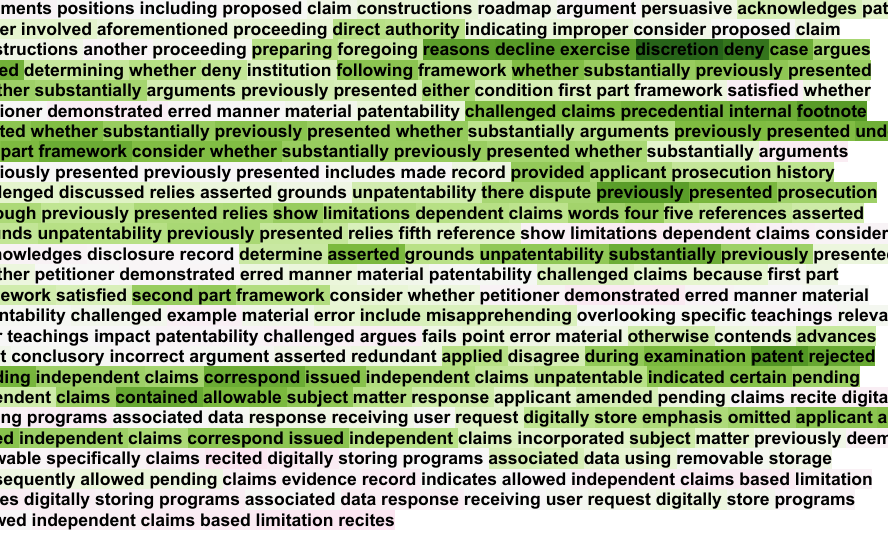
Figure 6. Text of the written decision granting trial in IPR2020-00806, with words highlighted according to the value of the attention vector at their positions (zero-padding edges to account for the kernel width of the CNN). The intensity of green corresponds to attention above the median for the vector as a whole (excluding the attention at zero tokens where the text was padded), and the intensity of pink corresponds to the magnitude of attention below the median. At top , we show the attention for a kernel width of 2, and at bottom , the attention for a kernel width of 8, which captures longer range